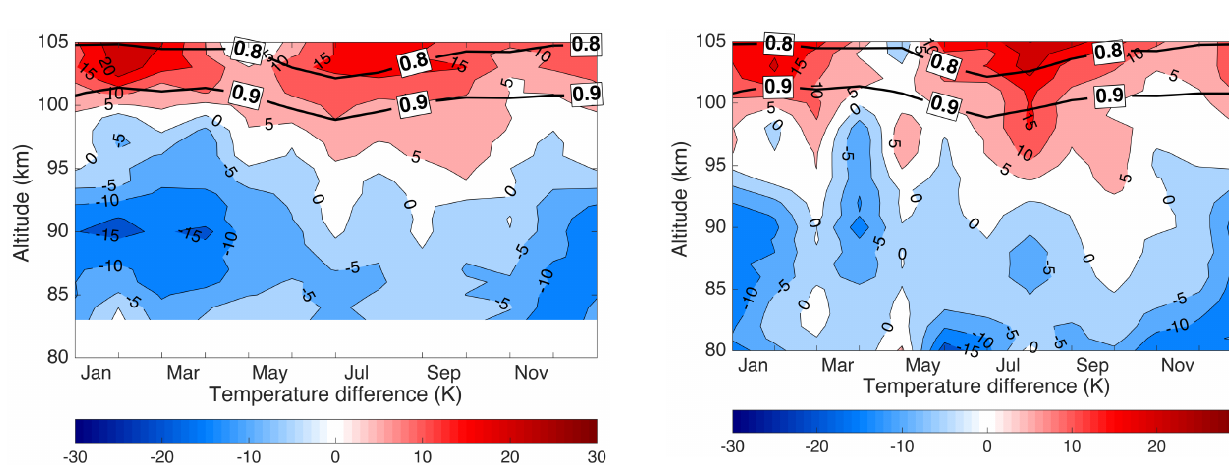
Figure 13. PCL temperature climatology difference from the CSU (1990–1999) sodium lidar climatology (PCL minus CSU). The hor- izontal black lines are the height below which the temperature cli- matology is more than 90% (0.9) and 80% (0.8) due to the mea- surements.